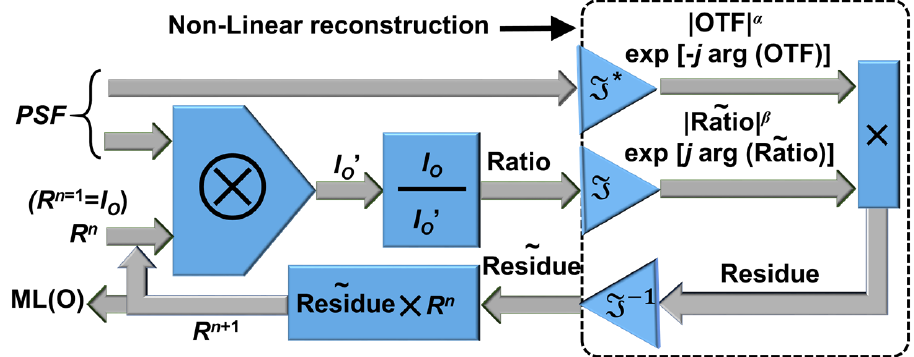
Figure 2. Optical configuration of the Golay-type diffractive imaging system consisting of LADISA with three sub-apertures.